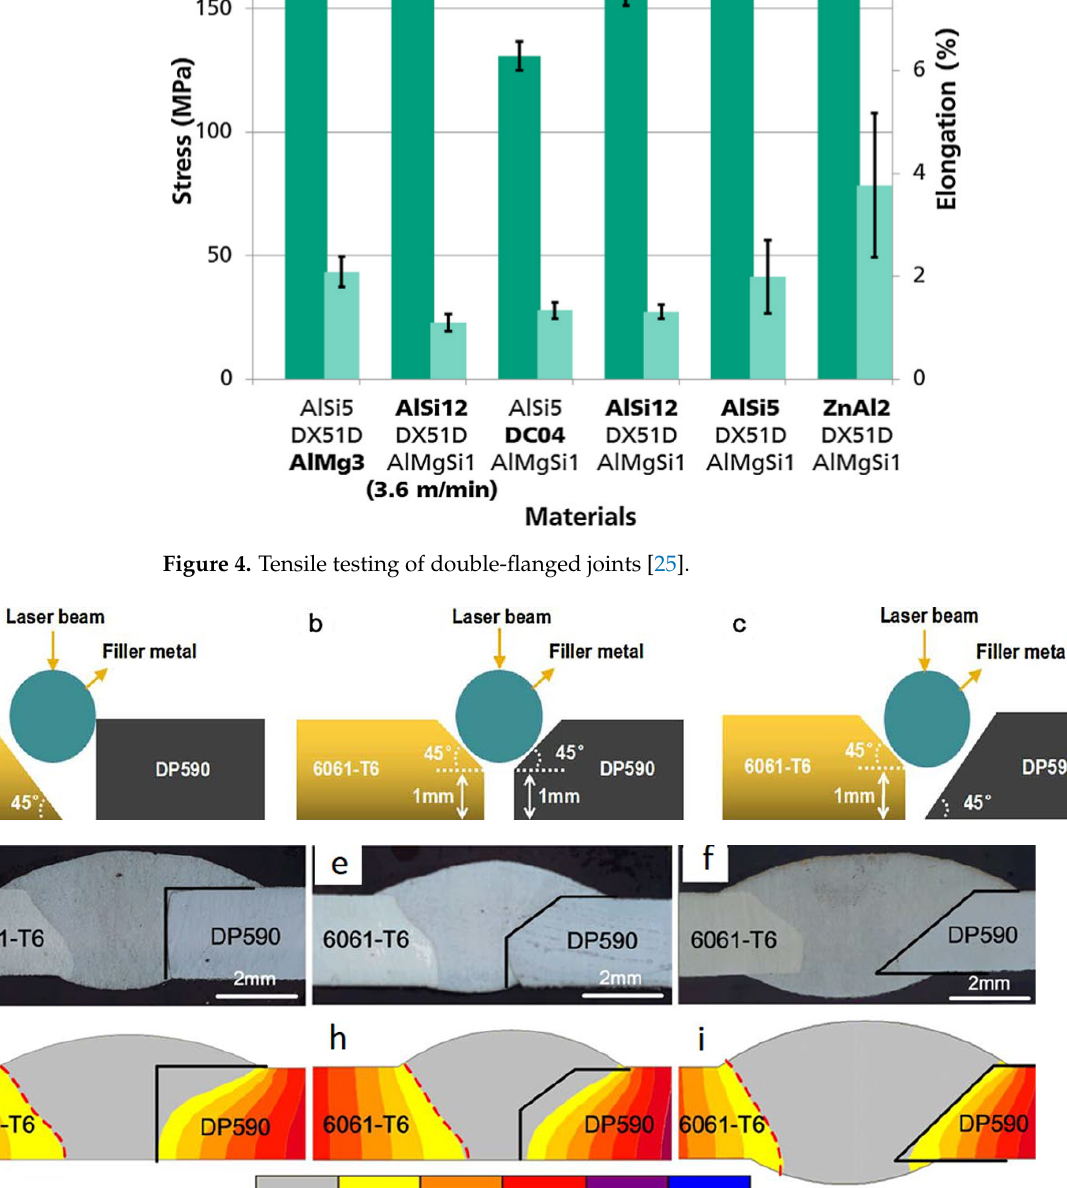
Figure 4. Tensile testing of double-flanged joints [25].